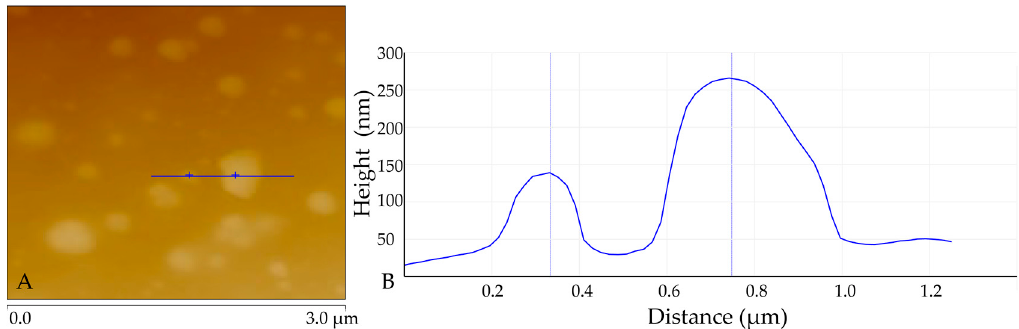
Figure 2. AFM analysis image of DES-lignin sample (D 12h ) extracted from willow by DES treatment at 120 ◦ C for 12 h. ( A ): height mode AFM image; ( B ) AFM-measured topographical height profiles corresponding to the line in (A).